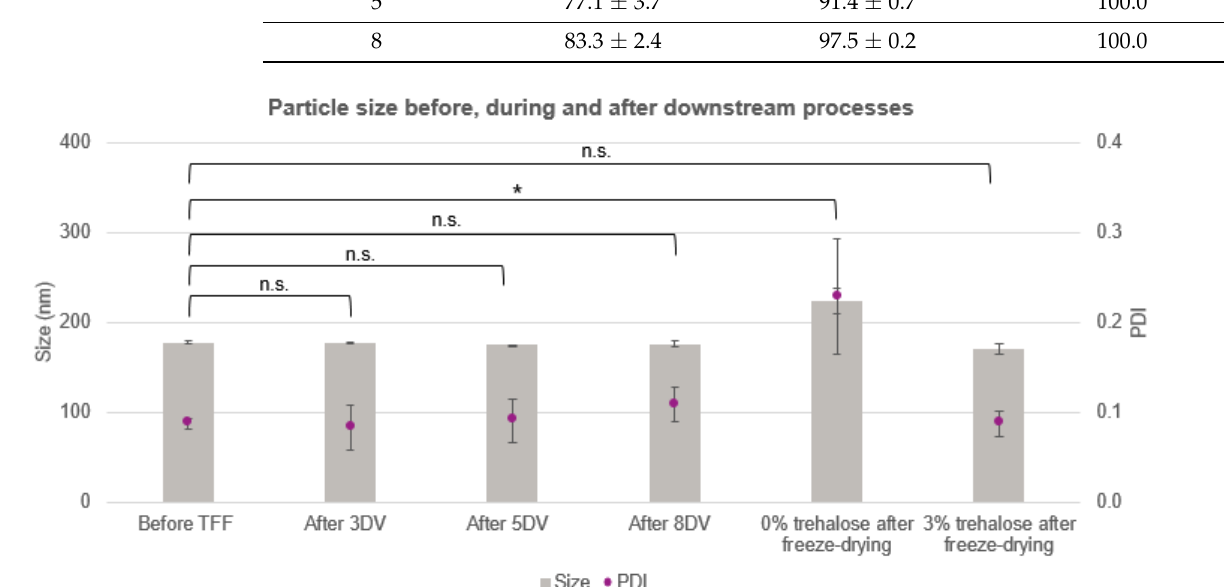
Figure 6. GPC spectra of the processed and untreated polymer under ultrasound. Data obtained for PLGA pure powder untreated (black), PLGA dissolved in the organic solvent (green), and PLGA treated under probe (red) and inline (blue) ultrasound technologies are presented.